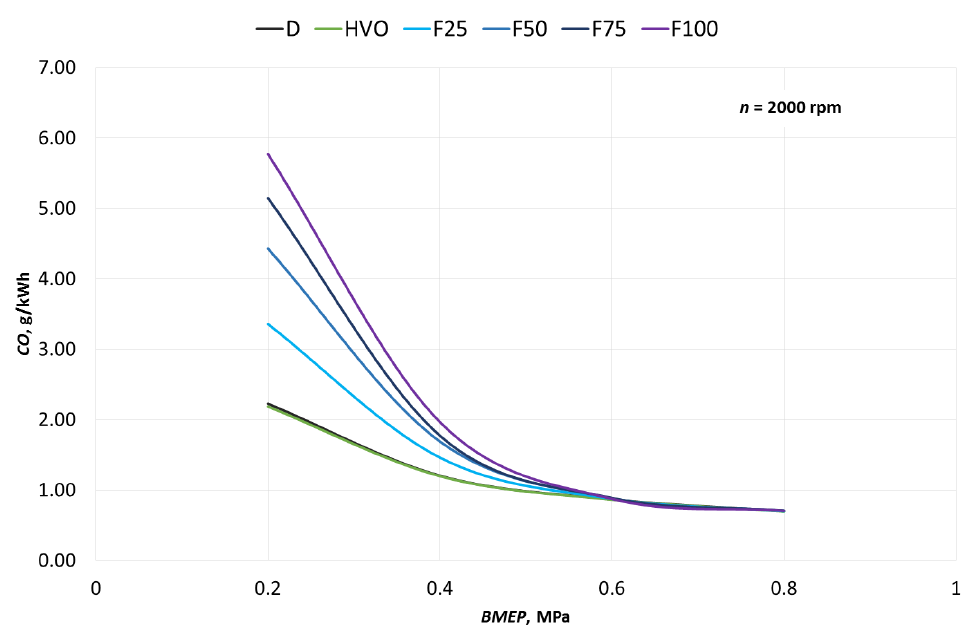
Figure 8. Dependence of carbon monoxide emissions on the load using different fuels.